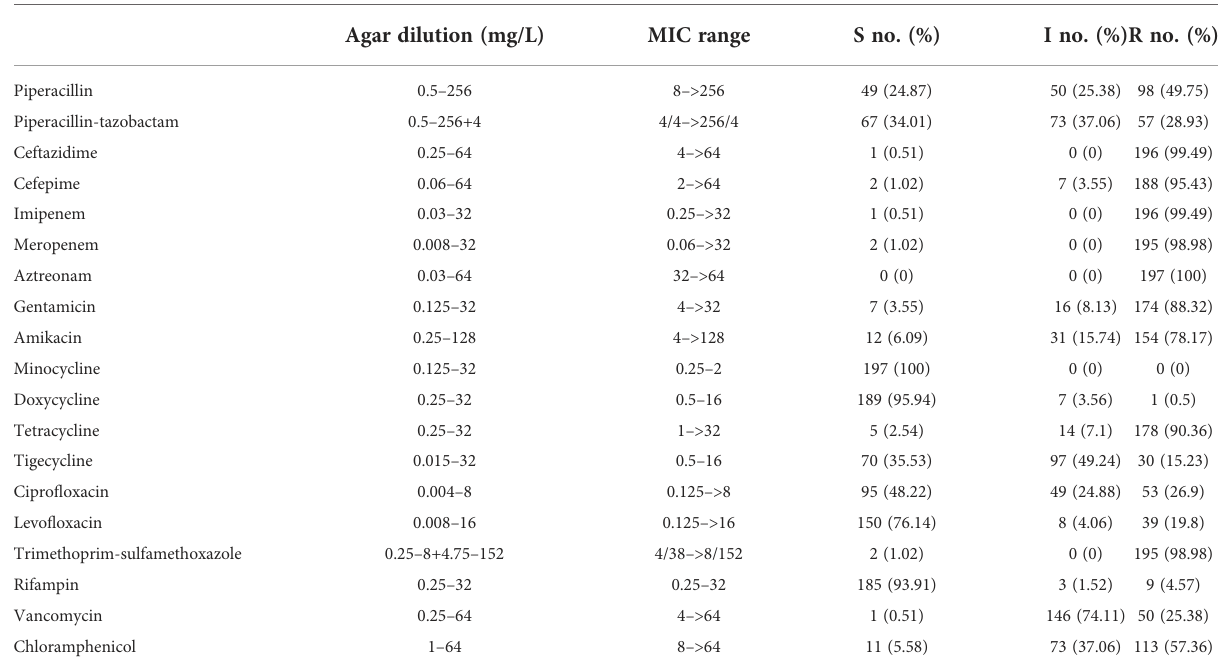
TABLE 1 Antimicrobial MICs (mg/L) and susceptible rates of 197 E. anophelis isolates determined using the agar dilution. Antimicrobial agent Susceptibility testing